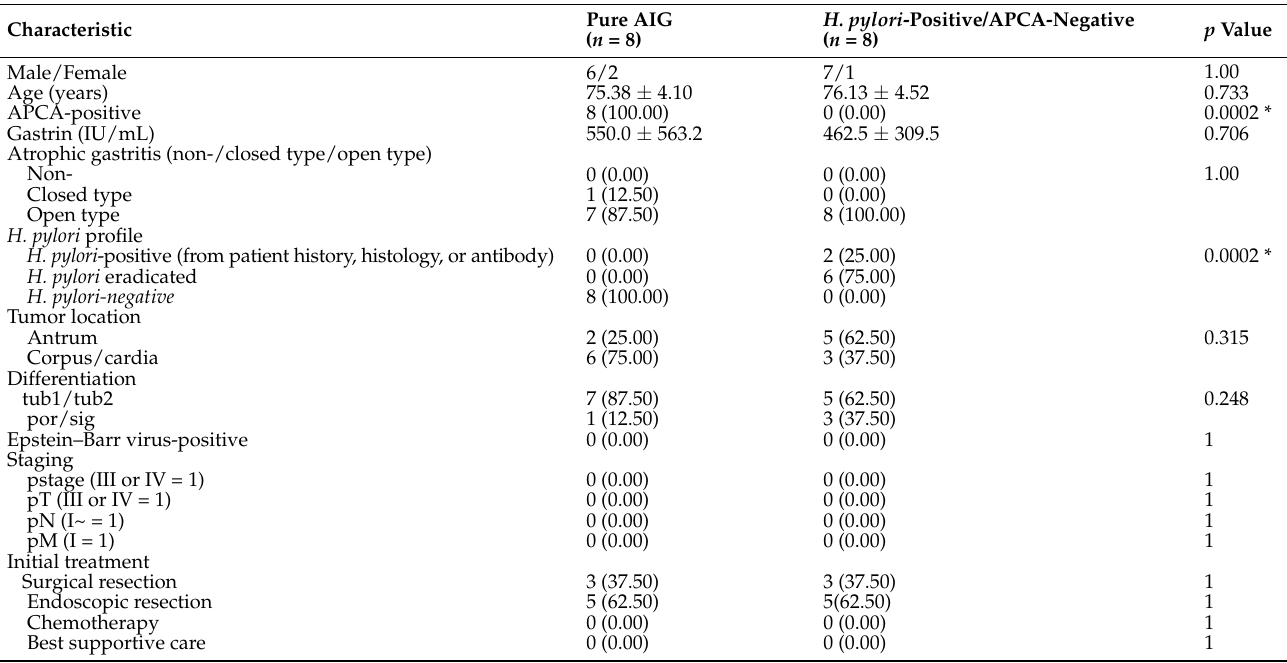
Table 3. Baseline characteristics of the matched cohort.